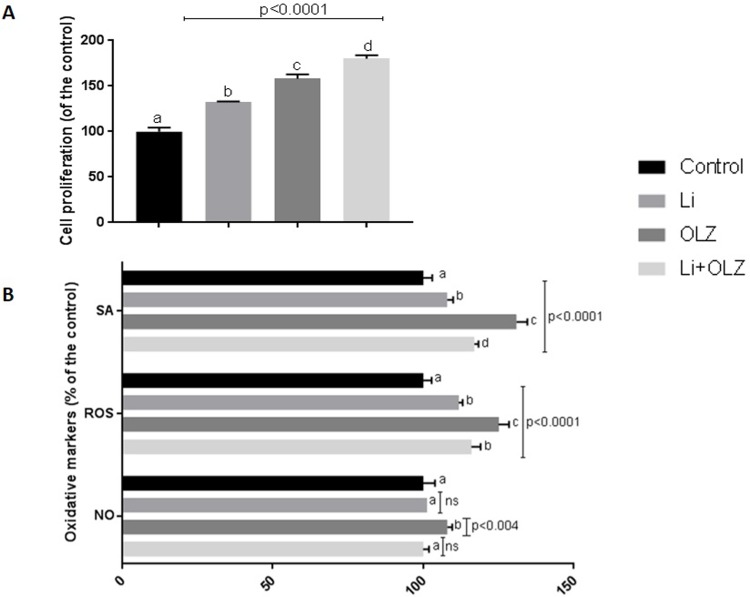
Interaction between OLZ (0.03 μg/mL) and Li (0.7 mEq/L) on proliferation (A) and modulation of oxidative markers superoxide anion (SA), reactive oxygen species (ROS), and nitric oxide (NO) (B). Treatments were compared by one-way analysis of variance (ANOVA), followed by the Tukey post hoc test. The different letters (i.e., A, B, C, D) indicate statistical differences in each treatment at p < 0.05. Treatments identified with A-letter were statistically s imilar to untreated-cells group (C).